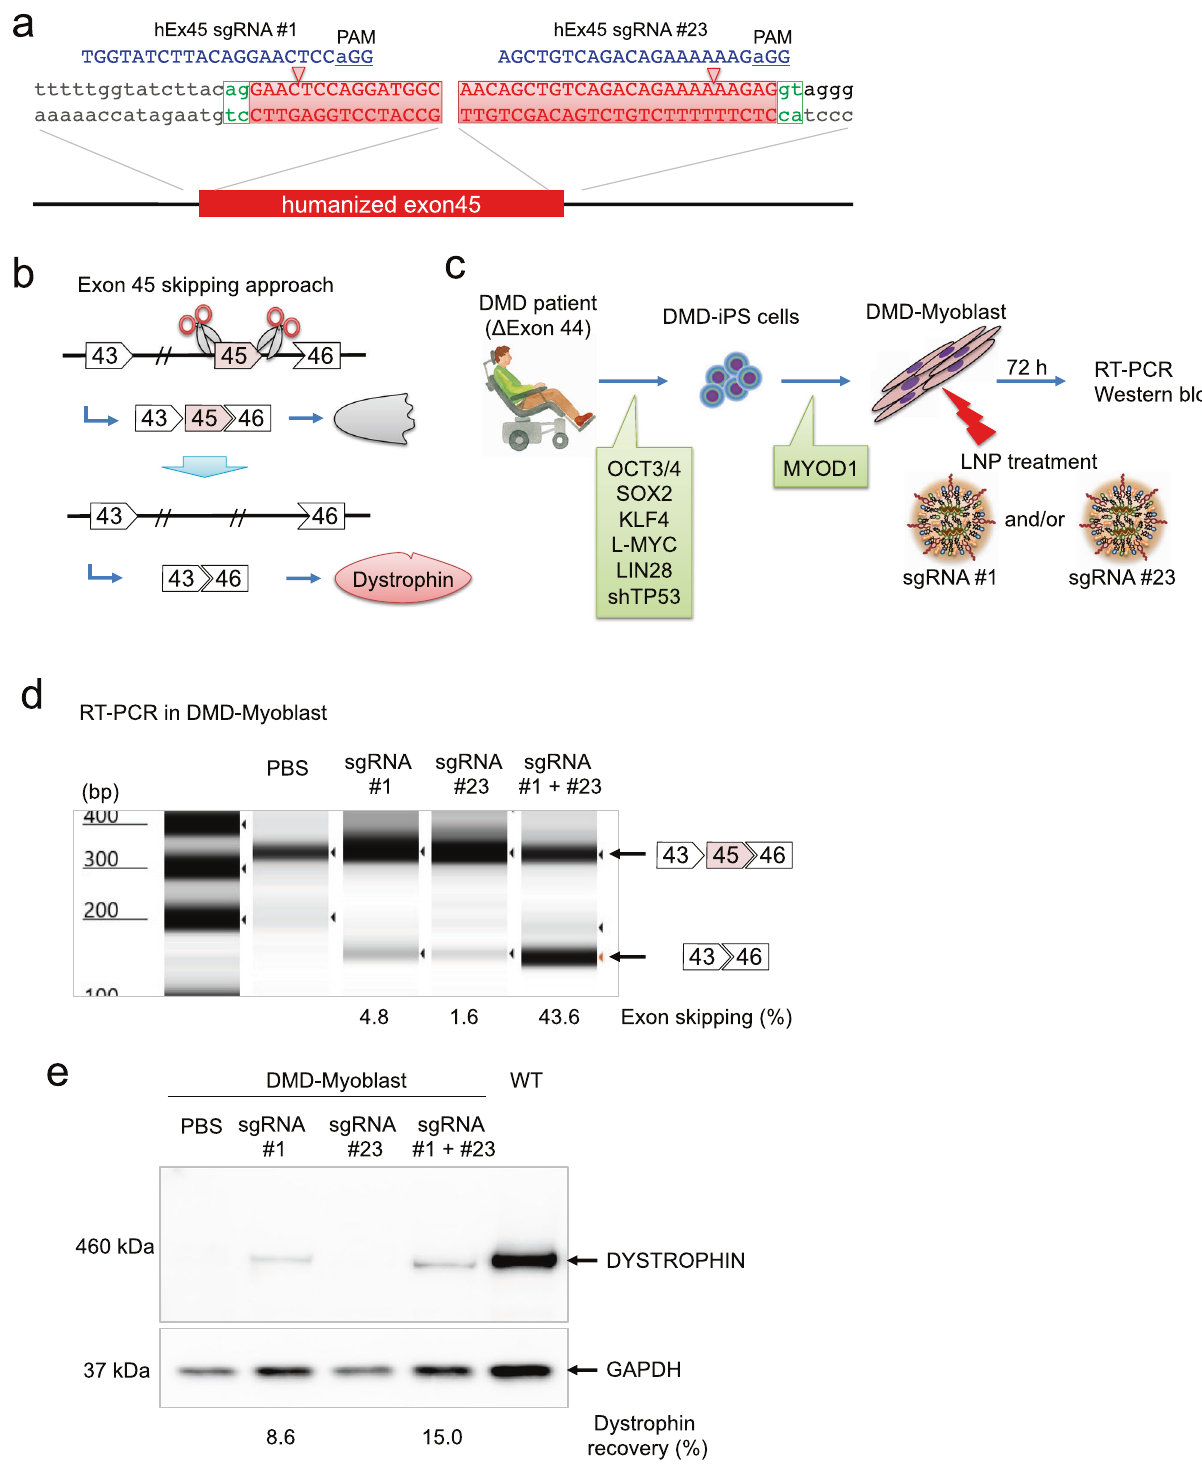
Fig. 2 Exon 45 skipping of human dystrophin using dual sgRNAs in DMD-iPS cells. a Two sgRNAs were designed to induce human exon 45 skipping. hEx45 sgRNA #1 and hEx45 sgRNA #23 target the splice acceptor and donor site, respectively. The human DMD exon 45 sequence is highlighted in red. b Therapeutic strategy of genomic exon skipping by the dual sgRNA approach. Exon 45 skipping results in restoration of the dystrophin protein by adjusting the protein reading frame. c DMD-iPS cells were derived from a DMD patient lacking exon 44. Myogenic differentiation of the DMD-iPS cells was induced by the overexpression of MYOD1 (DMD-Myoblast). LNP-CRISPR, which is a mixture of LNP-Cas9 mRNA (1 µ g mRNA) and LNP-sgRNA (total 1 μ g of sgRNA: either 1 μ g of #1, 1 μ g of #23, or 0.5 μ g each of #1 and #23), was administrated for 72 h. d Exon skipping ef fi ciency was measured by RT-PCR and TapeStation. n = 1 experiment is shown, but similar exon skipping were observed in more than 3 experiments. e Dystrophin restoration was measured by Western blot. n = 1 experiment is shown, but similar Dystrophin recovery were obtained in more than 3